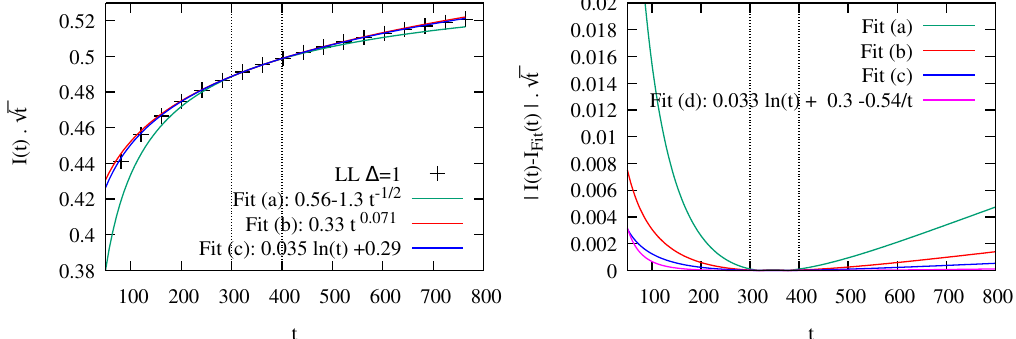
(cid:112) t as a function of time, for Figure 9: Left: LL current I ( t ) [ Eq. (5) ] multiplied by ∆ = 1. The numerical solution is compared with three fitting functions. These fits are done using only the interval [ 300,400 ] (dotted vertical lines), and the quality of these fits can be judged by the discrepancy between the data and the fitting functions (cid:112) t + cst / t . Fit (b) represents a outside this interval. Fit (a) corresponds to I ( t ) (cid:39) superdiffusive behavior I ( t ) (cid:39) t α with α > 0.5. The third one, (c), corresponding to (cid:112) I ( t ) (cid:39) ln ( t ) / t , appears to provide the best fit, and is in agreement with the results of Ref. [ 27 ] . The right panel shows the absolute value of the difference between the LL solution and the three fitting functions. Among the three fits (a),(b) and (c), the fit (c), which corresponds to a diffusive behavior with a multiplicative logarithm shows the best agreement with the numerical solution of the LL equation. Fit (d): including an additional 1 / t correction to the function of fit (c) makes the agreement almost perfect at the scale of this